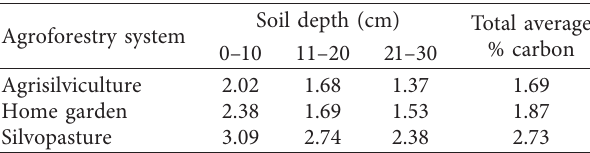
Table 2: Average bulk density (gm/cm 3 ) at various depths and agroforestry systems.